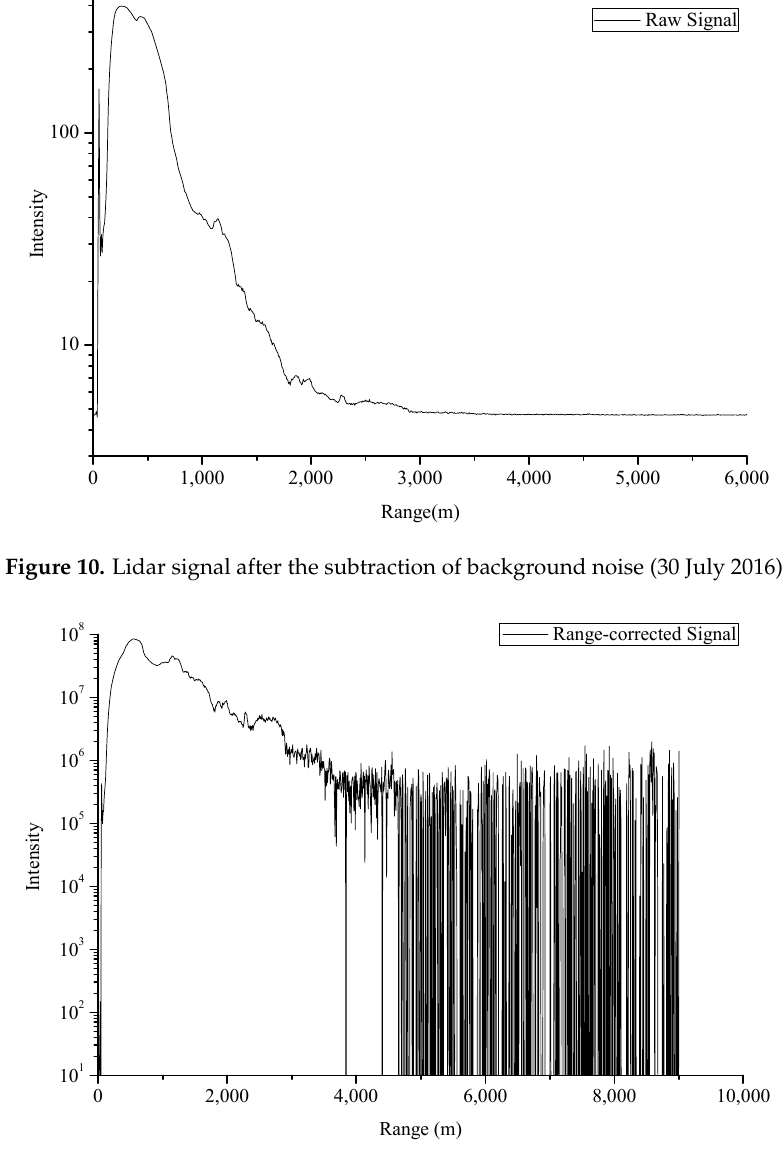
Figure 11. Lidar signal corrected by distance (30 July 2016).